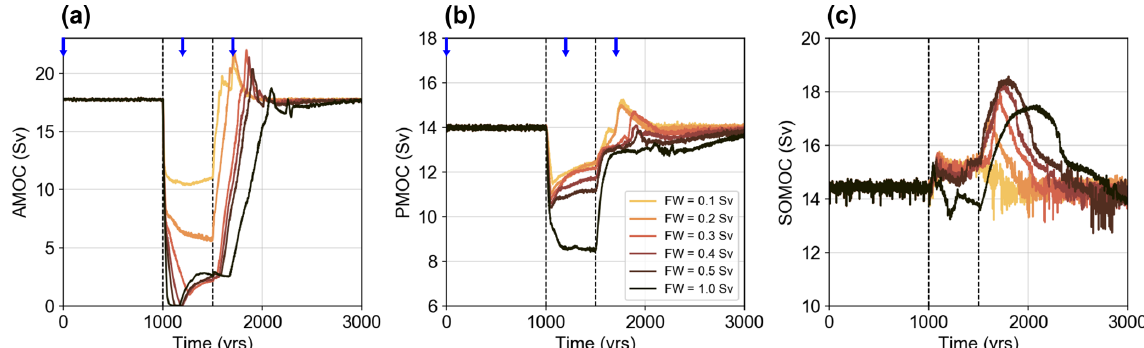
Figure 1. Response of circulation strength of the (a) AMOC, (b) PMOC, and (c) SOMOC to freshwater hosing experiments for the prein- dustrial control. The freshwater (FW) was added for 500 years (start and end are indicated by the vertical dashed lines) to the North Atlantic between 45 and 70 ◦ N (Fig. B1). PMOC and SOMOC circulation cells flow anticlockwise and are, hence, defined as negative by convention (cf. Fig. 2), but they are plotted here as positive values for convenience. Note the different y axes in the panels. Blue arrows in panels (a) and (b) mark time steps for which the stream functions are shown in Fig.